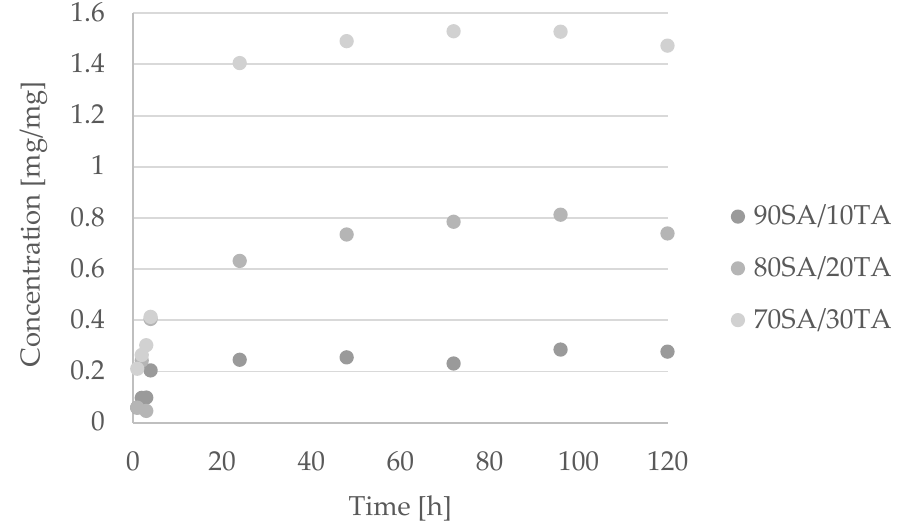
Figure 4. Total polyphenols released from sodium alginate/tannic acid films.